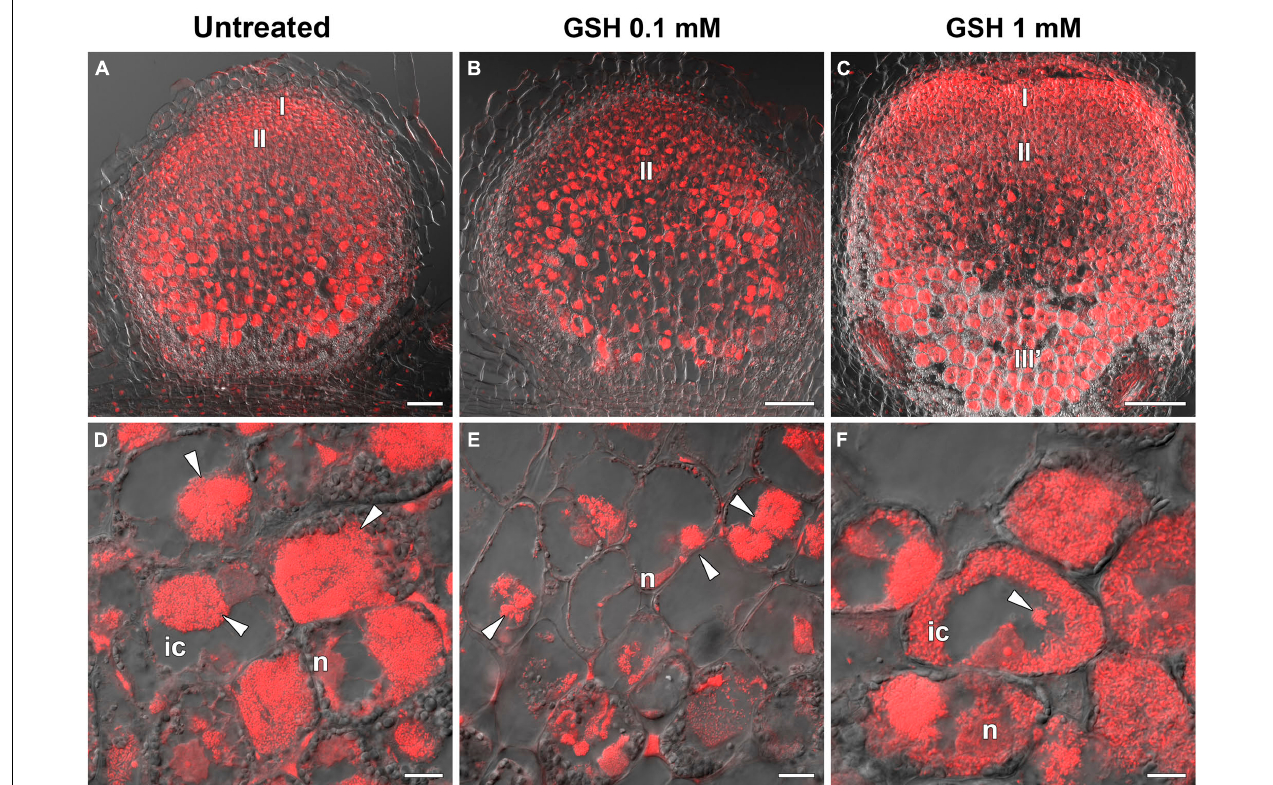
FIGURE 11 | Two-week-old nodules from mutant sym40-1 pea ( Pisum sativum ) plants treated with 0.1 mM or 1 mM glutathione (GSH). (A–C) General view of sym40-1 nodules; (D–F) infected cells of sym40-1 nodules; (A,D) untreated nodules; (B,E) nodules on plants treated with 0.1 mM GSH; (C,F) nodules on plants treated with 1 mM GSH. Confocal laser scanning microscopy images of 50- µ m-thick longitudinal sections. Merge of differential interference contrast and the red channel. A single optical section is presented, DNA (bacteria and nuclei) is shown in red. I, meristematic zone; II, infection zone; III (cid:48) , zone corresponding to